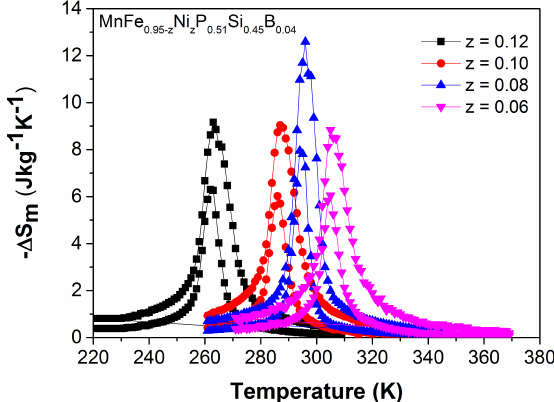
Figure 13. Magnetic entropy change as a function of temperature for a field change of 1 T (lower curve) and 2 T (upper curve) derived from isofield M B (T) curves measured upon cooling in the vicinity of TC for the Mn 1.00 Fe 0.95 − z Ni z P 0.51 Si 0.45 B 0.04 compounds.